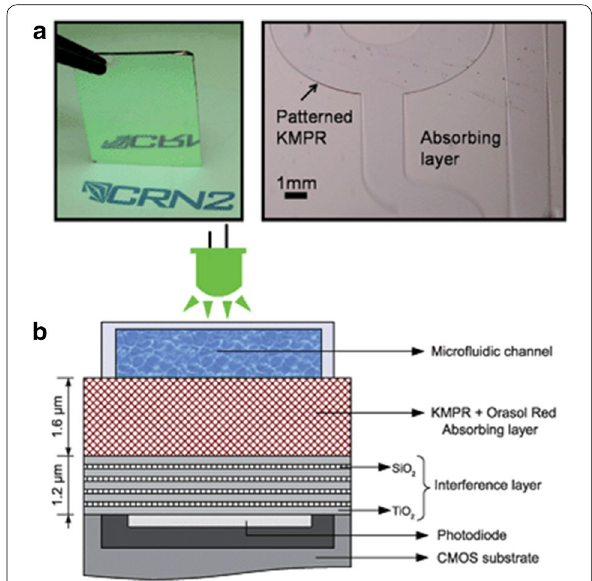
Fig. 5 Interference filter added on a microfluidic device: a inter‑ ference filter deposited on glass substrate (left) and patterned microfluidic channels on absorbing layer (right); b overall schemat‑ ics (reproduced from [73] with permission, © 2009 Royal Society